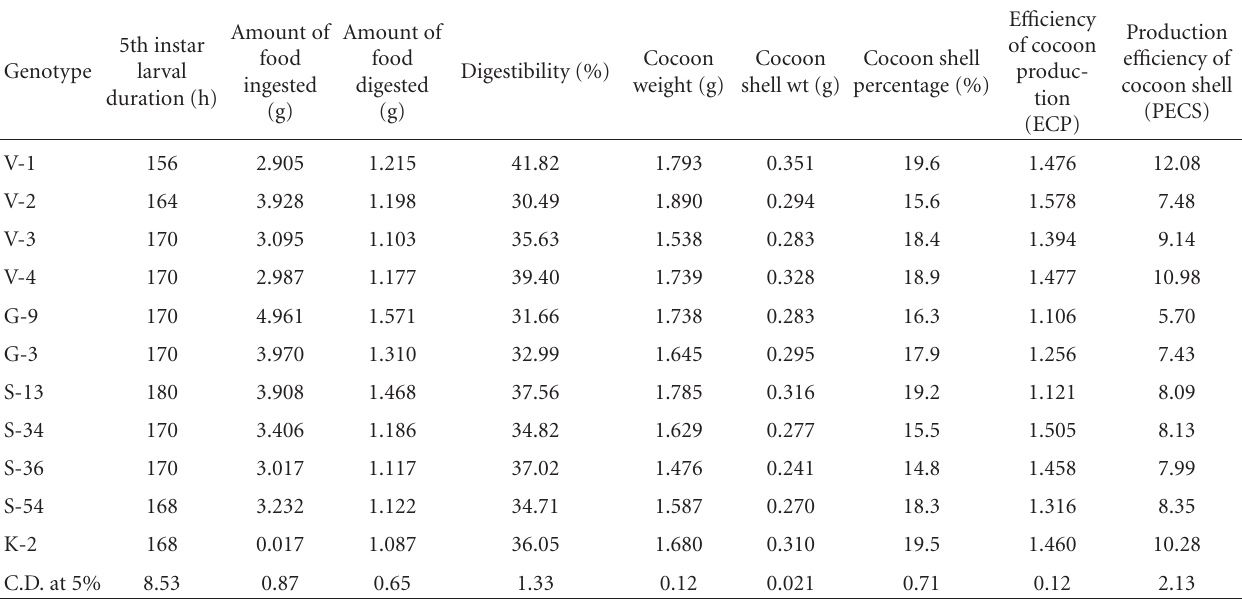
Table 1: Results of silkworm rearing utilizing mulberry leaf of di ff erent genotypes by polyvoltine